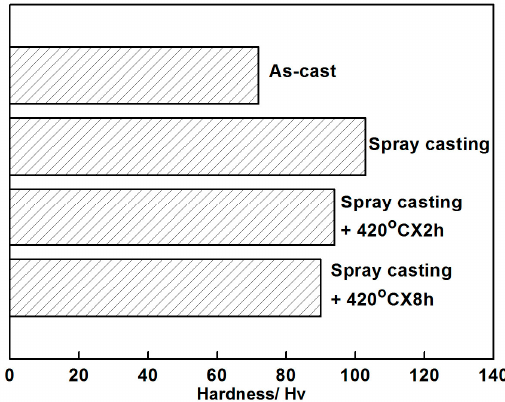
Figure 10. Microhardness of the AZ91D+0.75Ce alloys fabricated by different methods. 225